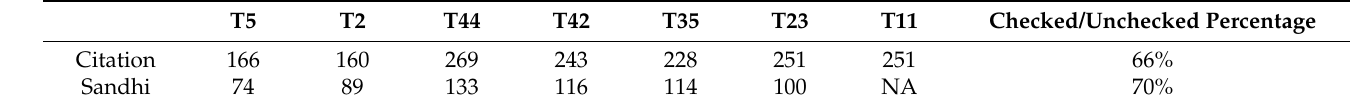
Table 10. Duration of each tone in citation and sandhi forms (in ms) and the percentage of checked tone duration to unchecked tone